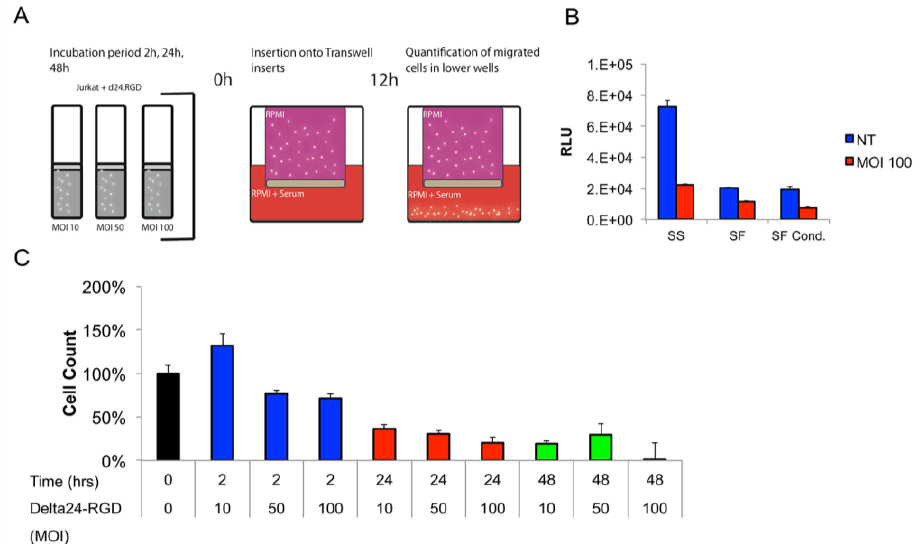
Figure 3. The Jurkat T-cell cell migration ability is influenced by Delta24-RGD